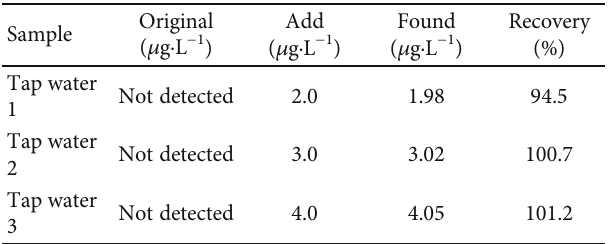
Table 3: Determination of Pb 2+ in di ff erent tap water samples (mean of three determinations).